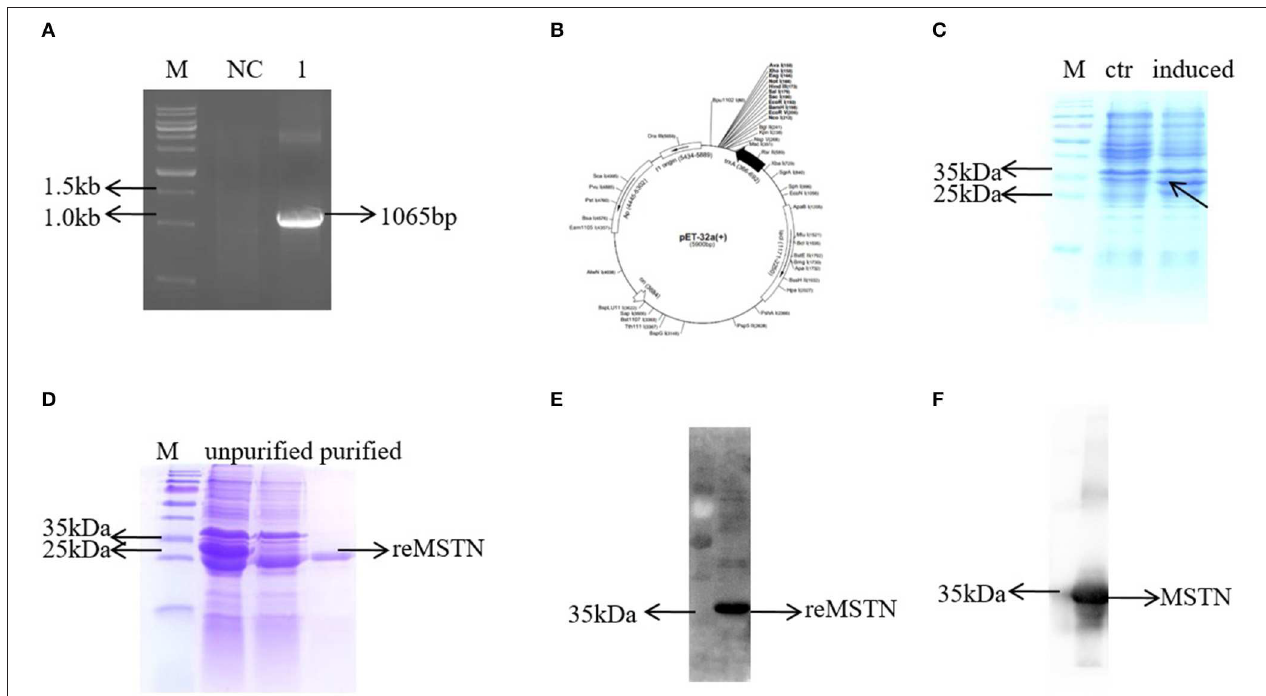
FIGURE 4 | Development of the MSTNb anti-rabbit antibody. (A) The mstnb ORF was cloned by PCR. (B) Schematic diagram of recombinant plasmid pET32a-MSTNb. (C) The induced expression of recombinant protein. (D) Purification of recombinant protein. (E) The purified protein was verified by western blot. (F) Mstnb anti-serum was detected, dilution ratio was